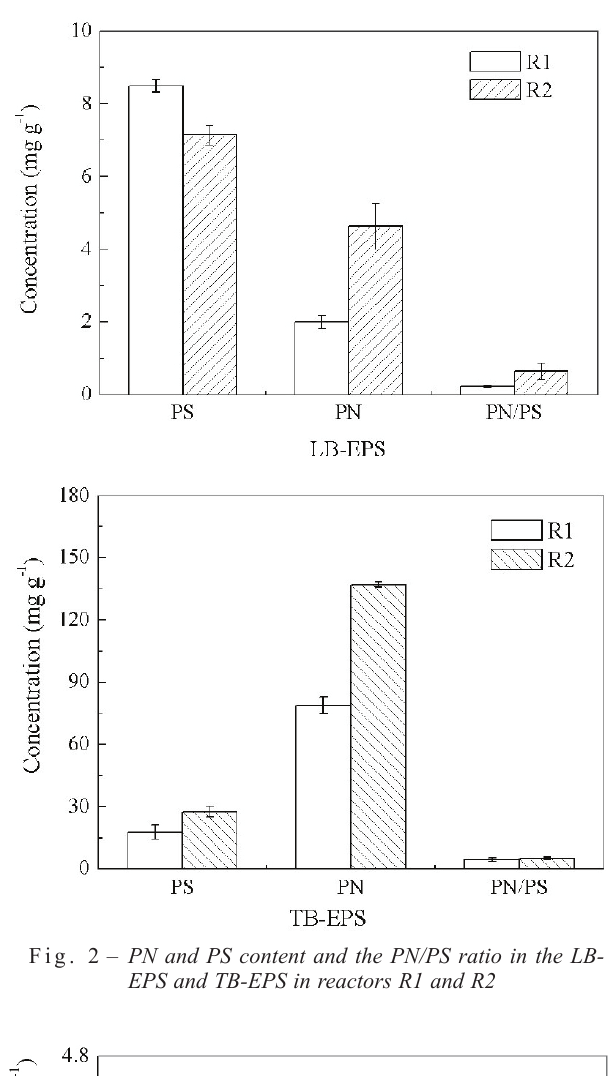
Fig. 2 – PN and PS content and the PN/PS ratio in the LB- EPS and TB-EPS in reactors R1 and R2